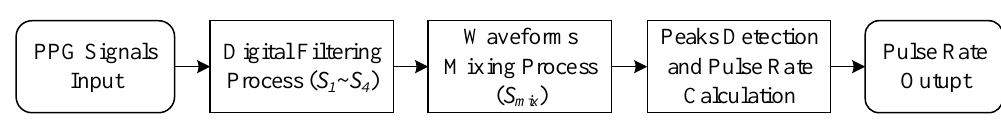
Figure 3. Signal processing flow in the